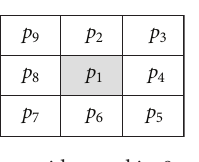
Figure 2: Centre grid 𝑝 1 and its 8 neighbor grids.